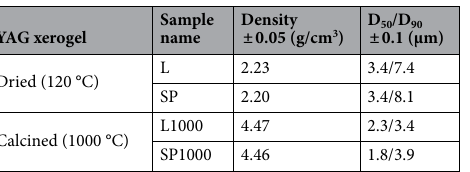
Table 1. Measured density, D 50 and D 90 corresponding to the number distribution for the dried and calcined xerogels.